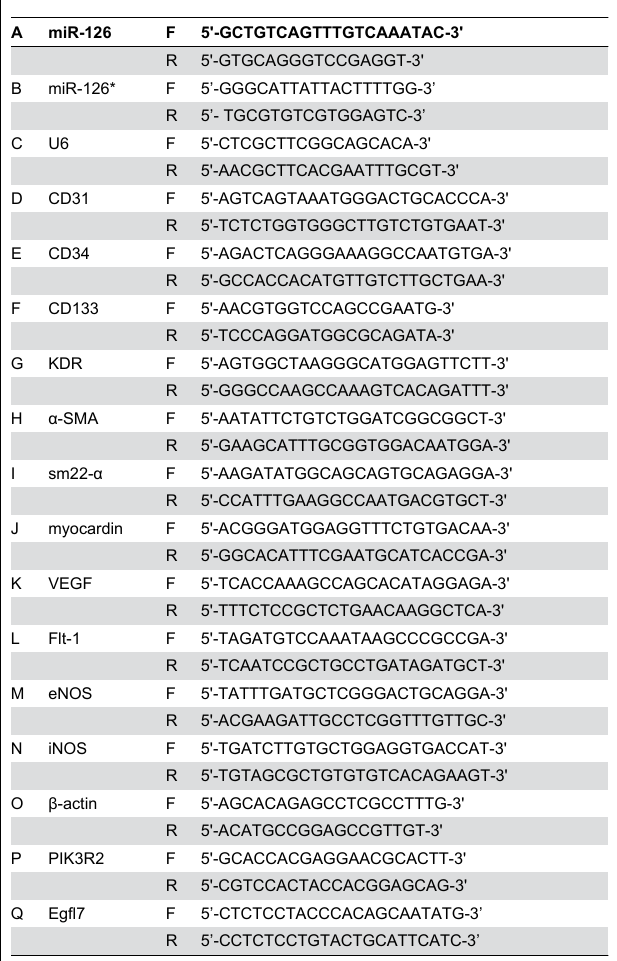
Table 1. PCR primers used for